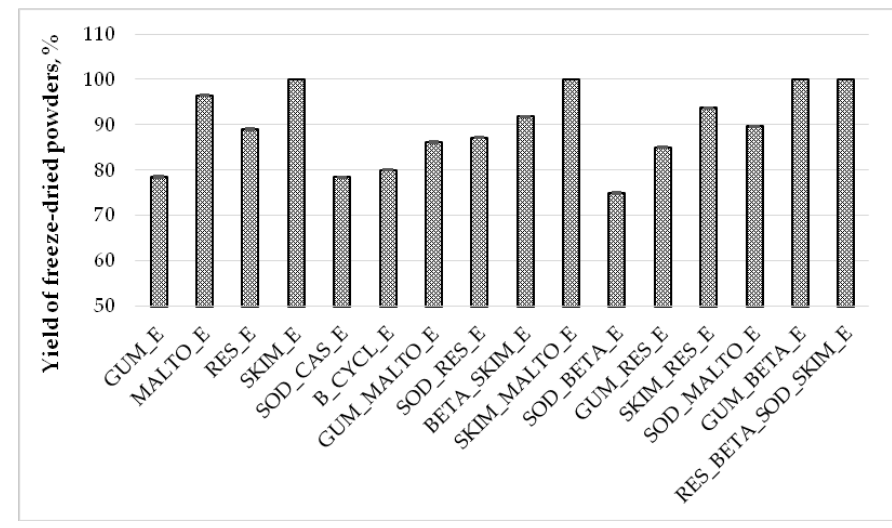
Figure 2. Yield of freeze-dried powders (%) obtained using different wall materials and mixtures.